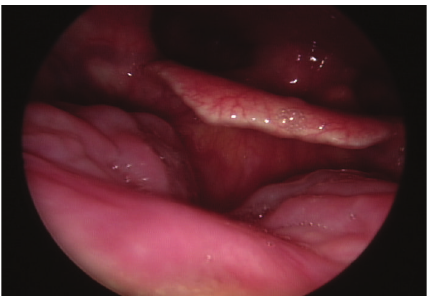
Figure 4: Laryngoscopy at the 6-month follow-up. No evidence of tumor recurrence was